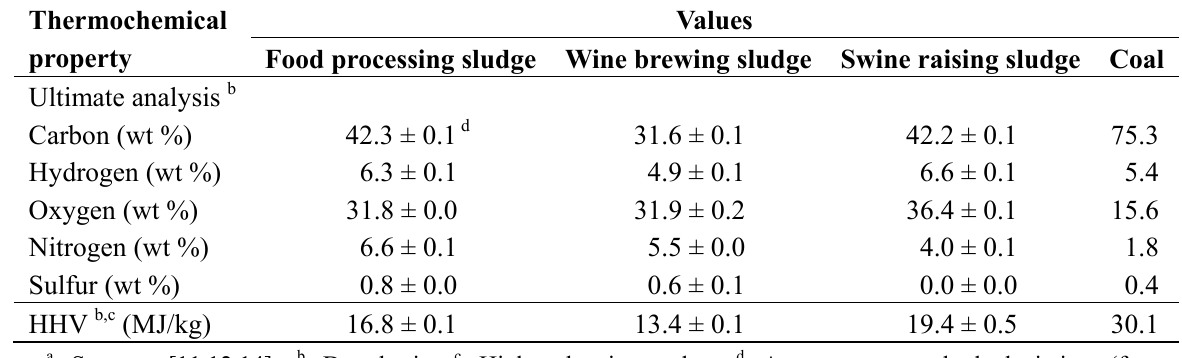
Table 1. Thermochemical characterization of dried sludge a